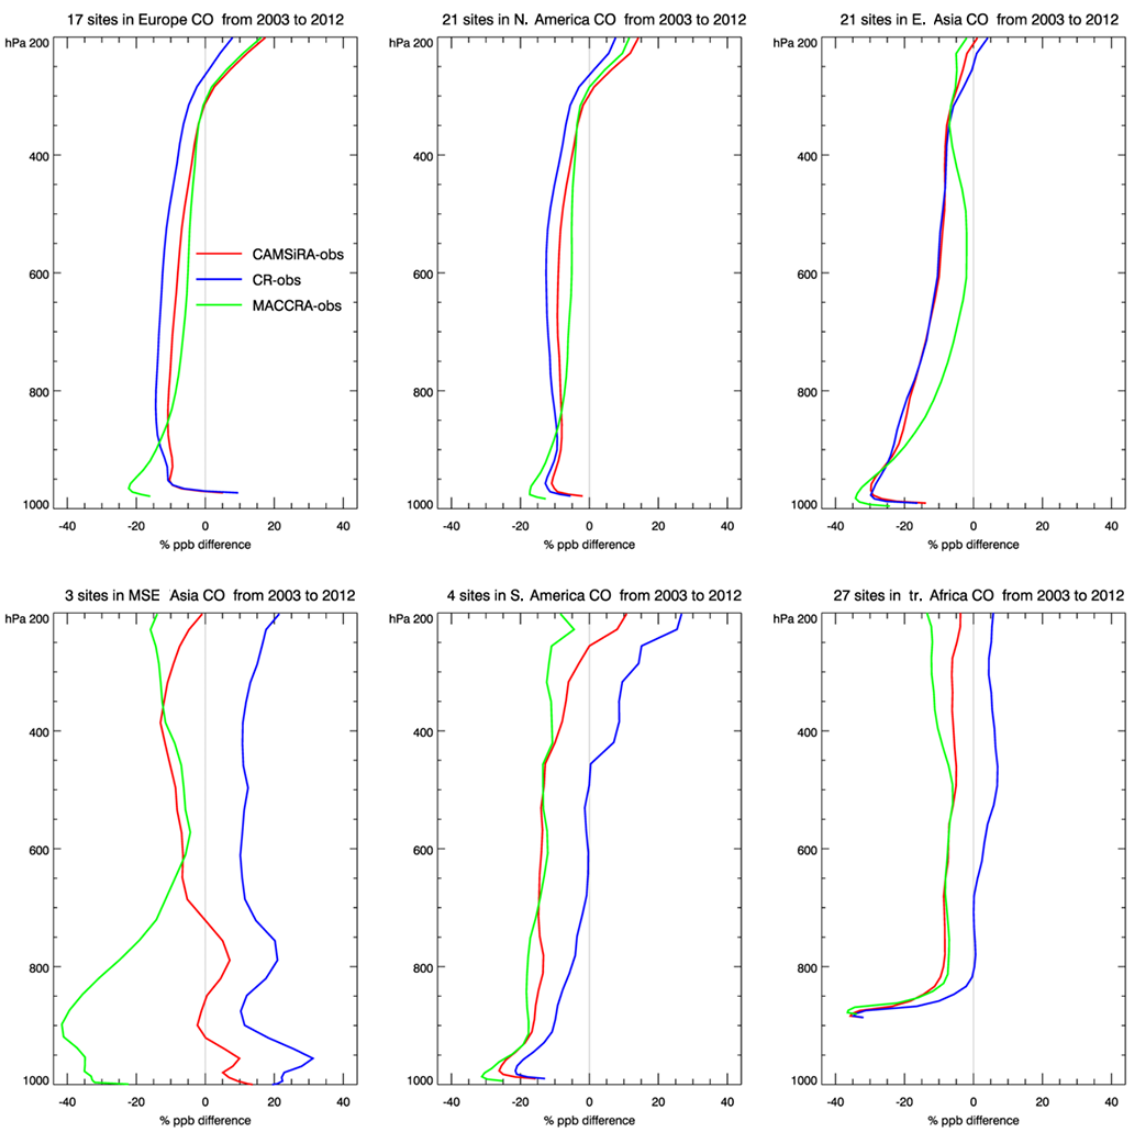
Figure 5. Average relative bias (%) in CO of CAMSiRA, MACCRA and the CR compared with MOZAIC–IGAOS flight profiles averaged over different regions (see Table 3) for the period